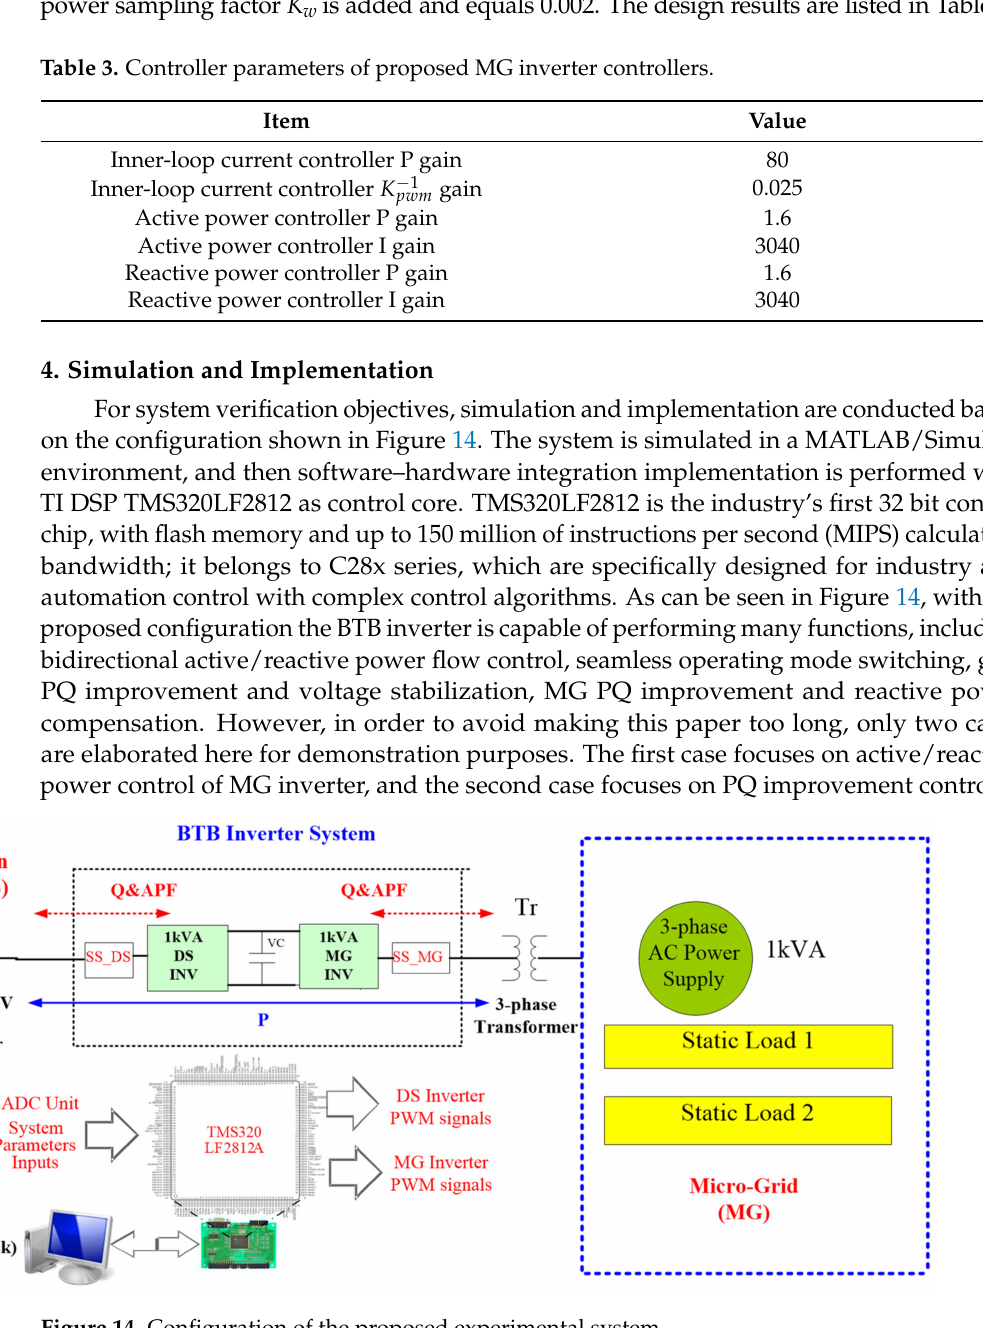
Figure 14. Configuration of the proposed experimental